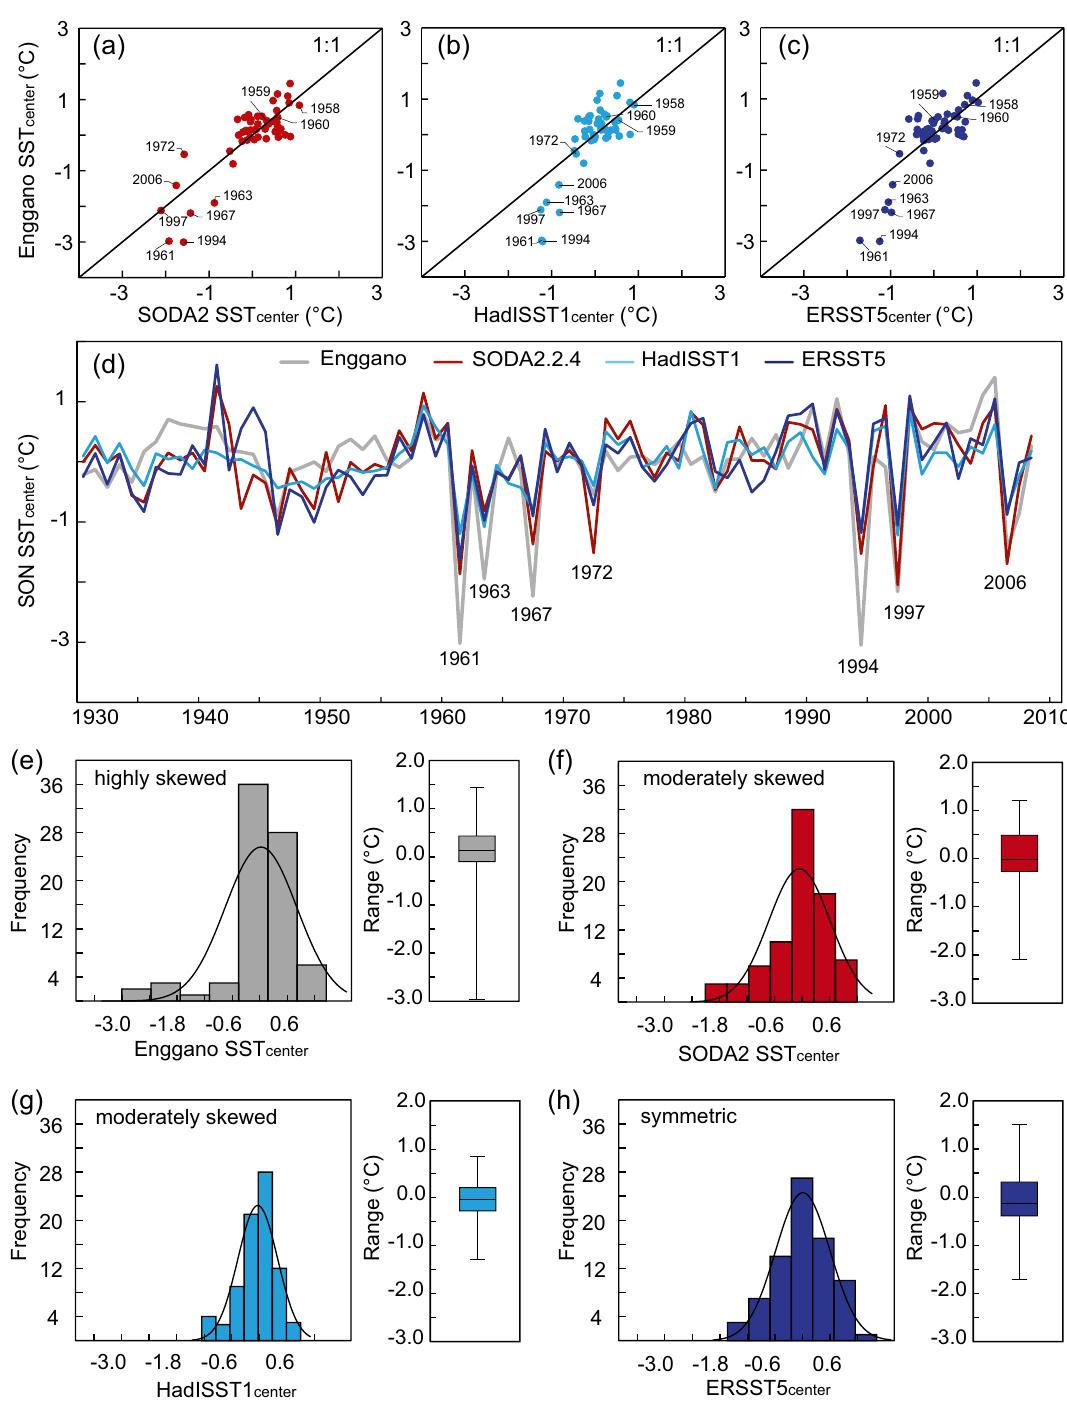
Figure 5. Scatter plots ( a – c ), time series ( d ), histograms and boxplots ( e – h ) of September–November SSTs from various SST products compared with Enggano coral SSTs for the time period of 1958–2008 ( a – c ) and 1930–2008 ( d – h ). Note the extreme cooling during the pIOD events of 2006, 1997, 1994, 1967, 1963 and 1961, which is underrepresented in HadISST1 and ERSST5 ( b – d ) and the highly skewed distribution of the Enggano SSTs compared to the moderately skewed (SODA2, HadISST1) and symmetric (ERSST5) distribution of historical products ( e – h ). Boxplots show median, interquartile range and maxima/minima (whiskers) of the datasets. All time series have been centred to their